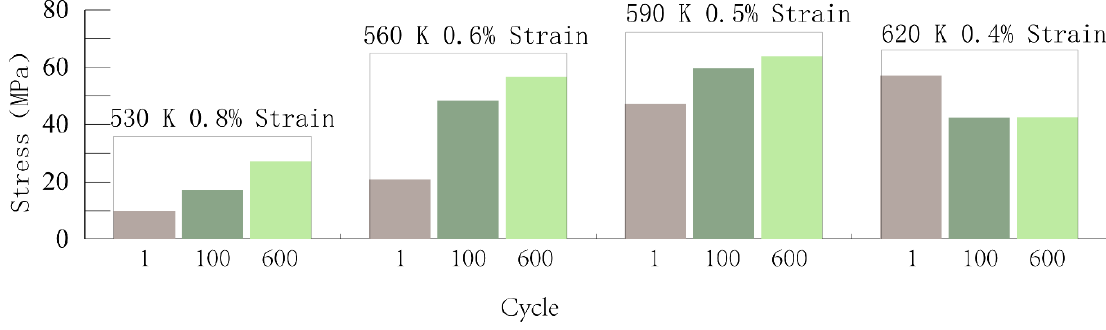
Figure 14. Summary of relaxation stresses under different conditions.